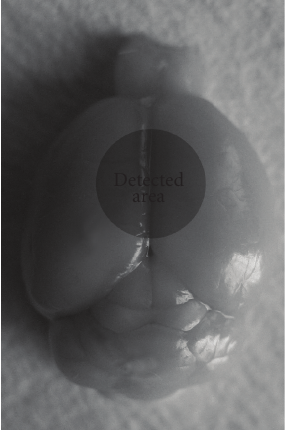
Figure 1: Schematic representation of the area taken for